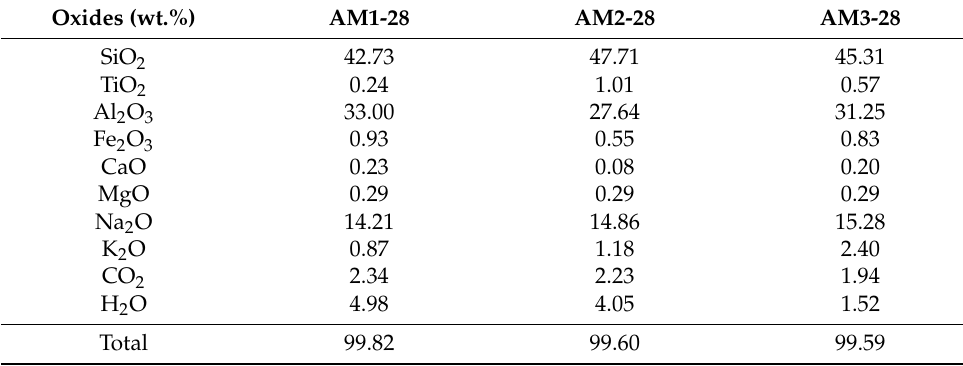
Table 2. The oxides composition of alkali-activated AM-28 samples.